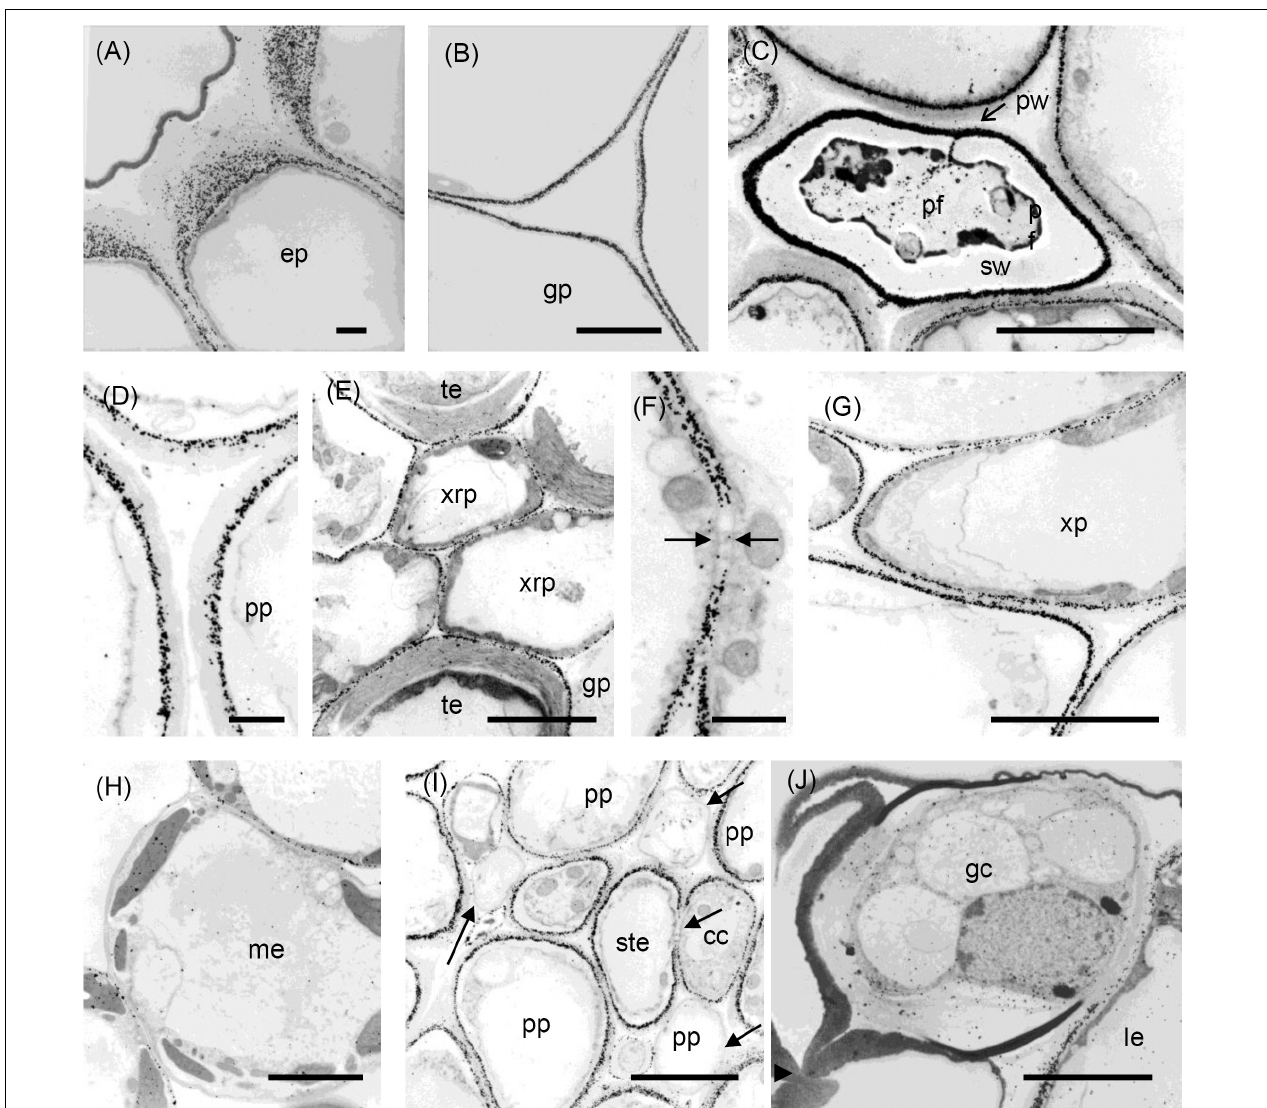
FIGURE 6 | Transmission electron micrographs of transverse sections cut from a rosette leaf of an 8-week-old chicory plant and immunogold labelled with LM5. (A) The outer wall of epidermal cells in the midrib, showing that labelling gradually increased from the cuticle to the plasma membrane, but was largely absent from the middle lamella. (B) A ground parenchyma cell in the midrib, showing labelling of the primary walls, but no labelling of the middle lamella or the corners of the intercellular spaces. (C) A phloem fibre, showing that labelling was heavy and in a narrow region of the primary walls. (D) A parenchyma cell in the phloem cap, showing thick walls with labelling confined to the region near the plasma membrane. (E) The xylem, showing that labelling is absent in the secondary walls of the tracheary elements, but present in the primary walls of tracheary elements and xylem ray parenchyma cells. (F) A ground parenchyma cell, showing no labelling of the pit field. (G) A xylem parenchyma cell, showing the same pattern of labelling as in (B) . (H) Mesophyll cells, showing that most walls were labelled, but a few were not. (I) Phloem parenchyma cells near the sieve tube elements, showing no labelling of the walls of some of the phloem parenchyma cells. (J) Stomatal guard cells, showing no labelling of the walls. cc: transfer cell; gp: ground parenchyma; ep: epidermal cell; gc: stomatal guard cell; le: lamina epidermis; me: mesophyll cell; pf: phloem fibre; pp: phloem parenchyma; pw: the primary wall; ste: sieve tube element; sw: the secondary wall; te: tracheary element; xrp: xylem ray parenchyma; and xp: xylem parenchyma; arrows show the absence of labelling. Bars: (A,D,F) 1 µ m; (B,C,E,G–J) 5 µ